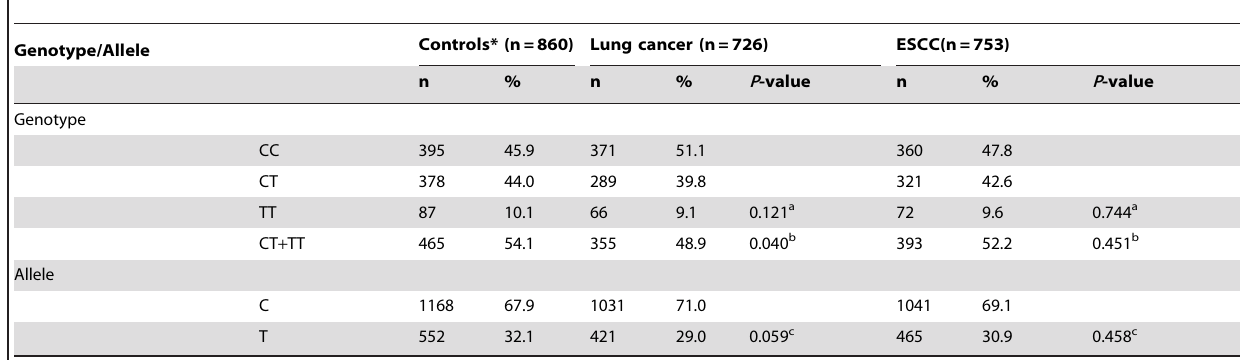
a Two-sided x 2 test of the difference in the genotype frequency distribution between cases and controls. b Two-sided x 2 test of the distribution of combined genotypes (CT +